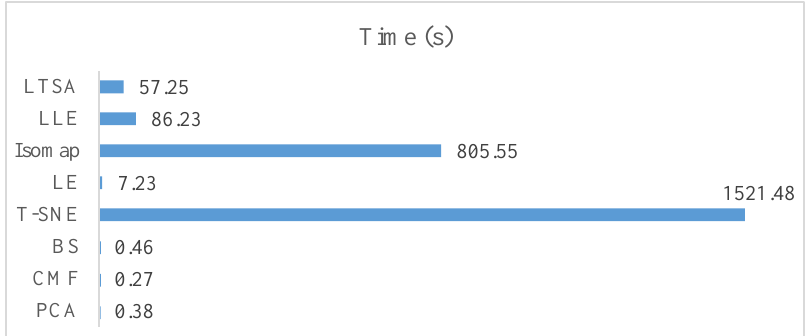
Figure 9. Average running time for each manifold algorithm.